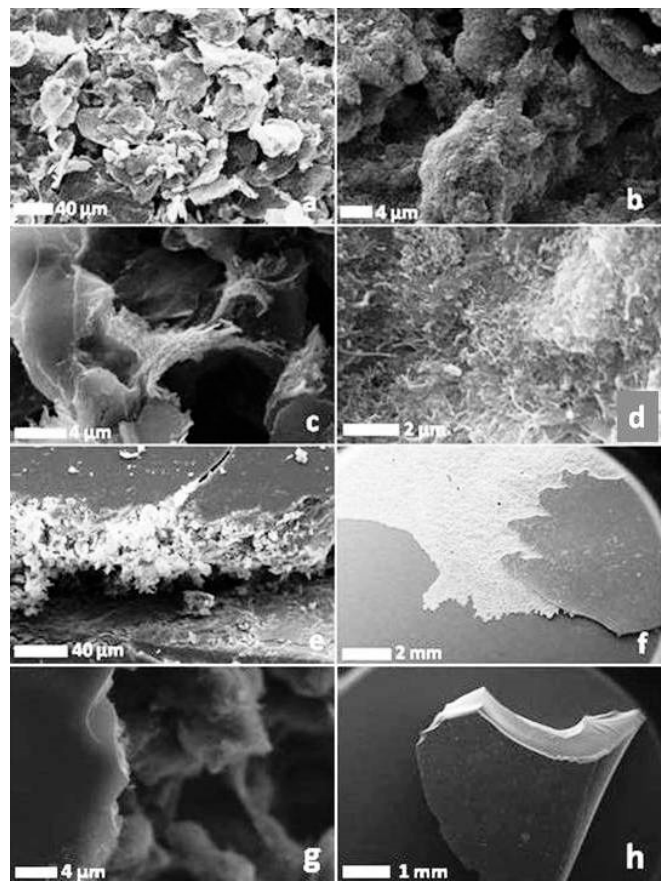
Figure 2. Scanning electron microscopy (SEM) images from the internal space of ( a ) PEGDA / graphene, ( b ) PEGDA / carbon nanotubes (CNTs), ( c ) PEGDA / Hybrid 70 / 30, and ( d ) PEGDA / f CNTs polymer composites. ( e , g ) The smooth surface of the polymer composite films and the appearance of nanofillers in cross-sections. ( f ) Sample of polymer composite, where the surface is partly removed, revealing the difference between the smooth surface and the rough internal. ( h ) The smooth surface and a cross-section of neat PEGDA polymer. The nanofiller percentage in all reinforced samples was 8.5% w/w.